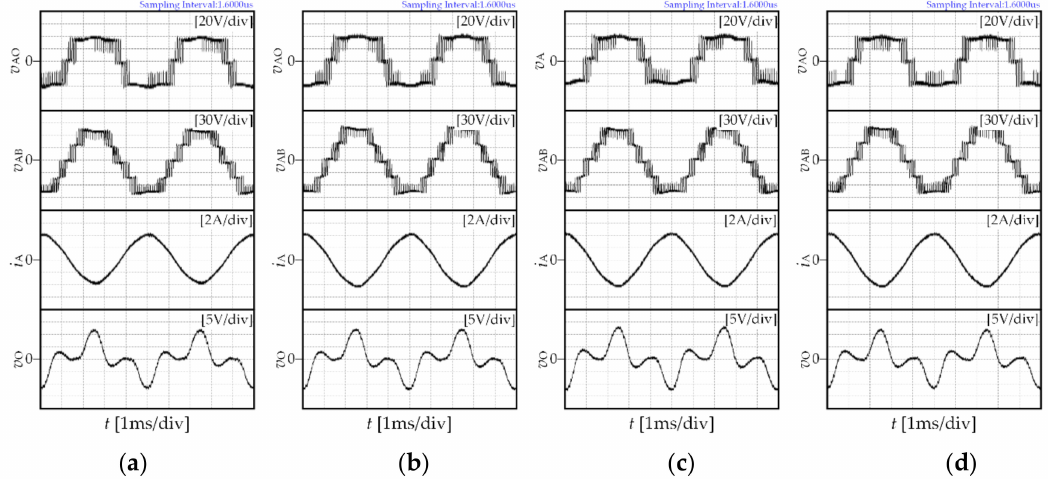
Figure 8. Experimental results of DPWM0–DPWM3 under two-phase load conditions when m ’ =